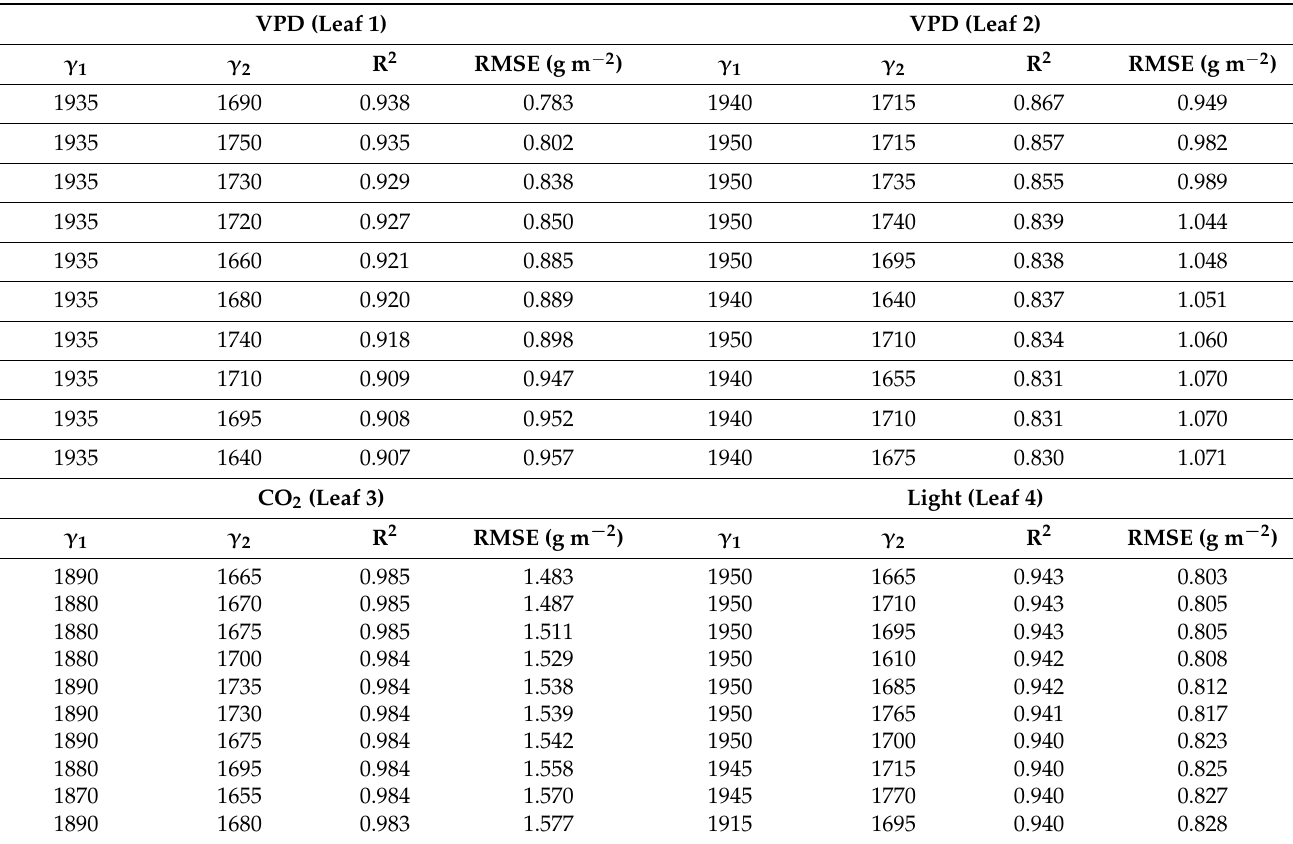
Table A2. Coefficient of determination (R 2 ) and root-mean-square-error (RMSE) for the top 10 most accurate linear regression models for estimating equivalent water thickness (g m − 2 ) using normalized ratio indices calculated with wavelengths γ 1 and γ 1 under incremental increases in vapor pressure deficit (VPD) and constant CO 2 concentrations and light intensity (Leaf 1 and 2), light intensity and constant levels of VPD and CO 2 concentrations (Leaf 3), and D) CO 2 concentrations and constant levels of VPD and light intensity (Leaf 4). VPD (Leaf 1) VPD (Leaf